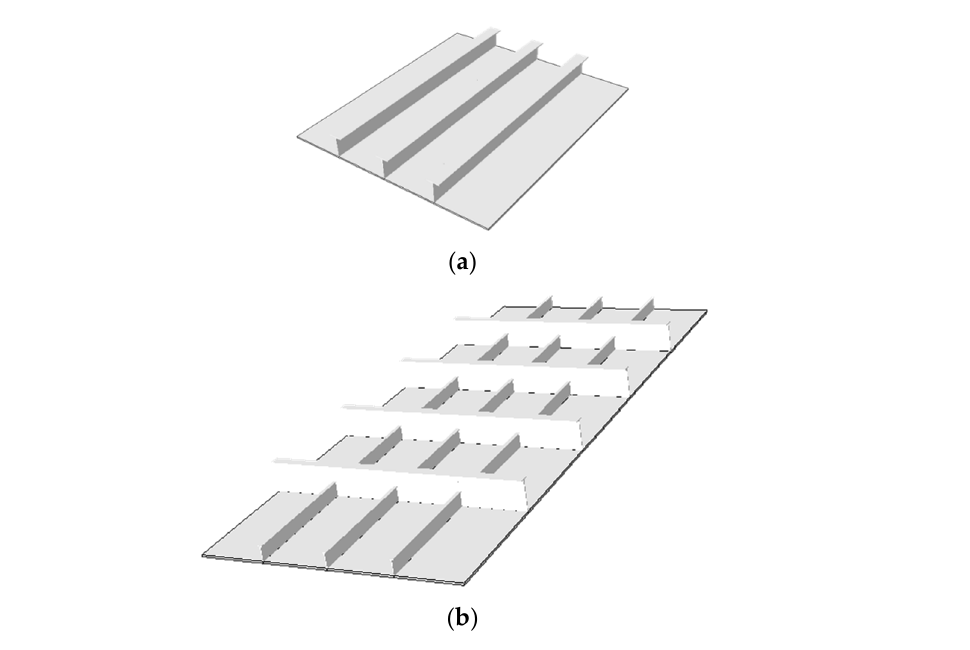
Figure 1. One-way (single-bay) stiffened panel ( a ) and cross-stiffened panel ( b ). For elastic design, local loads (e.g., hydrostatic and hydrodynamic pressure) com- bined with global loads (hull girder load effects) are taken into consideration [2]. Hull